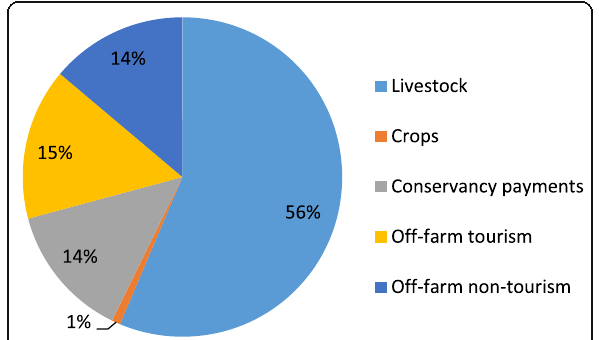
Figure 3 Contribution of different livelihood activities to